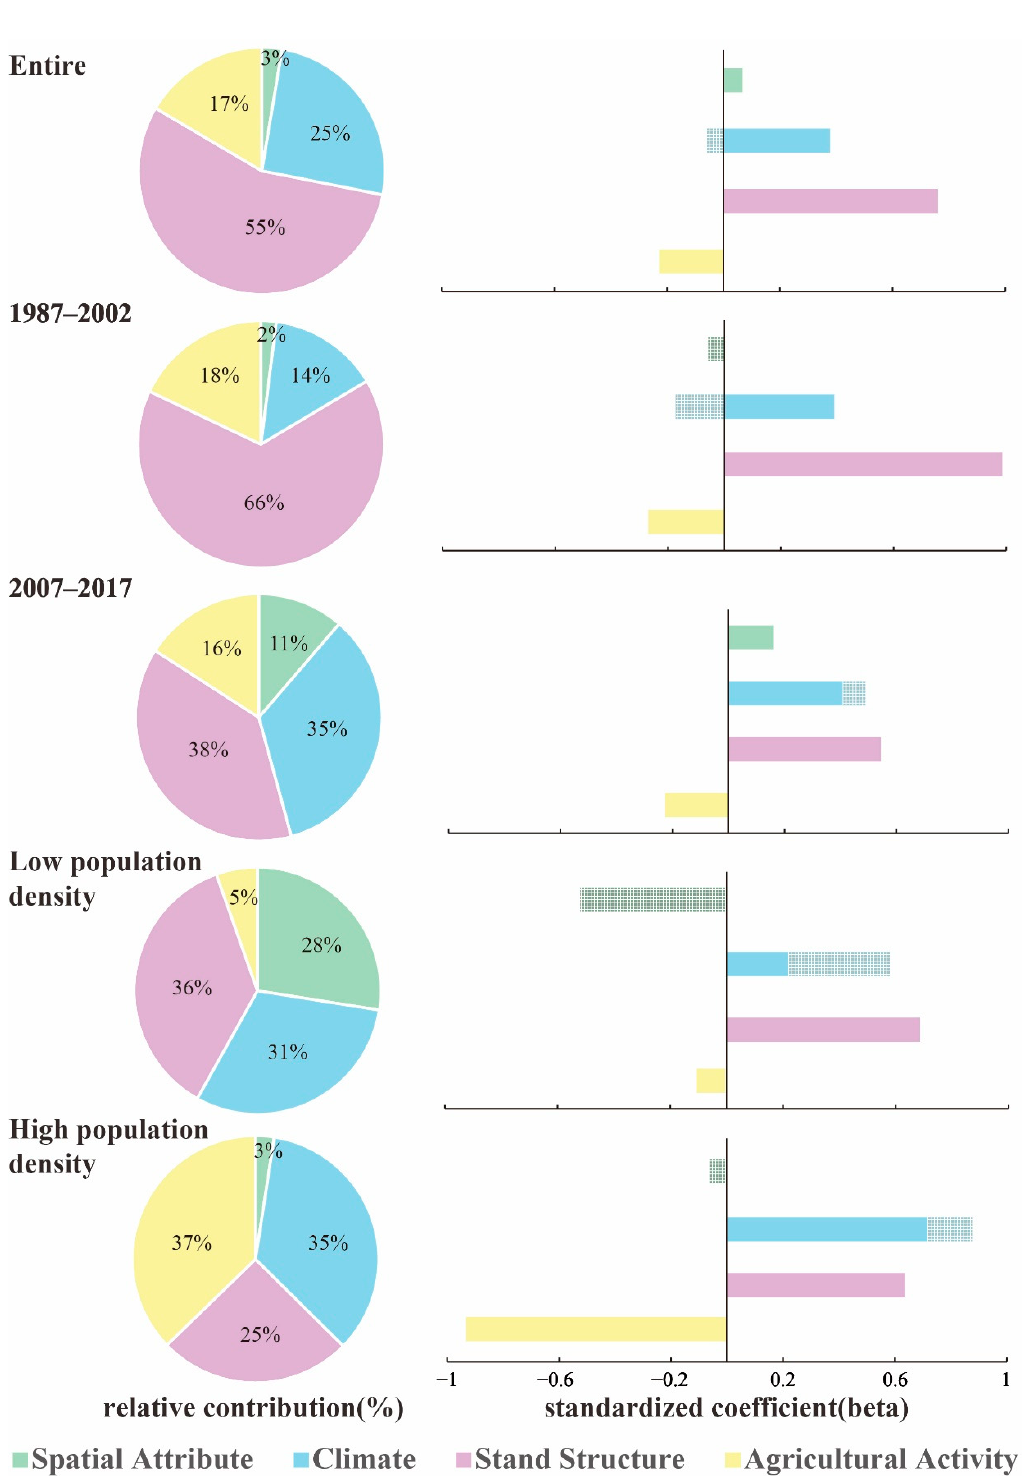
Figure 6. Standardized coefficient and relative contribution of the four drivers on the AGB changes. The pies show the relative importance of each driver on the AGB changes. The filled bars indicate the direct effect, and the striped bars indicate the indirect effect.